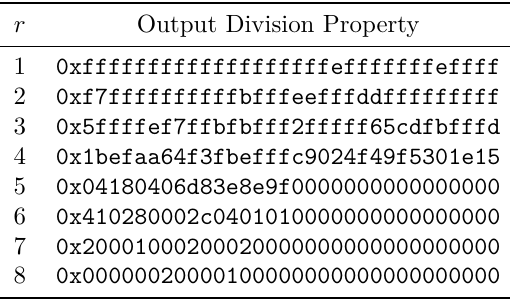
Table 4: Division Properties for Clyde-128 over r rounds, for r ∈ { 1 , . . . , 8 } out of 12.